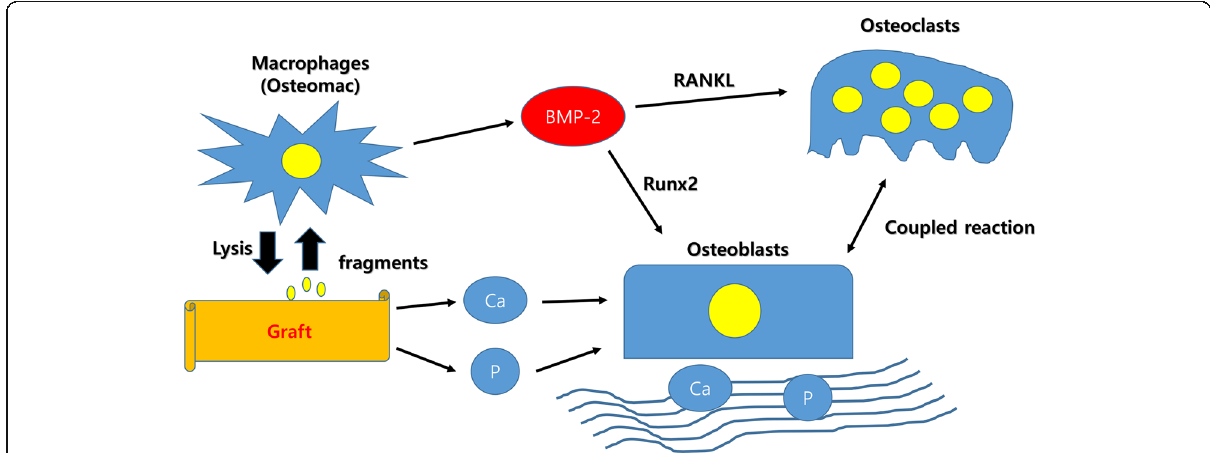
Fig. 1 Schematic drawings of the bone regeneration process after grafting. As degrading graft by macrophages, degraded fragments may influence the macrophage. Some fragments stimulate macrophages to produce bone morphogenic protein-2 (BMP-2). It activates both osteoblast and osteoclast. Runx2, runt-related transcription factor-2; RANKL, receptor activator of nuclear factor kappa-B